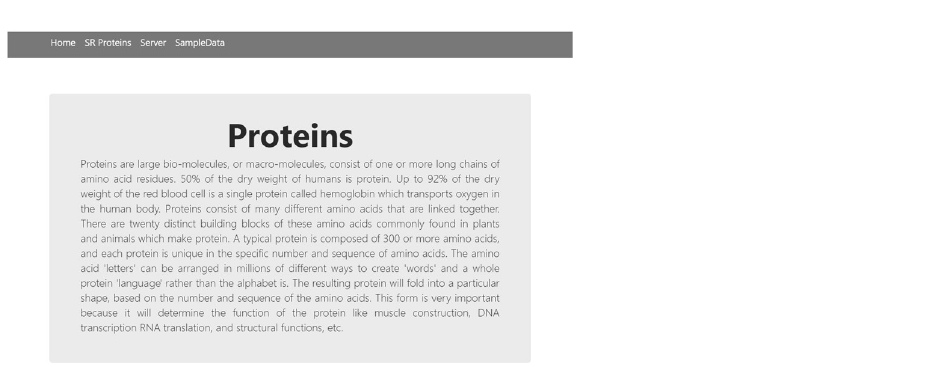
Figure 14. Home page of